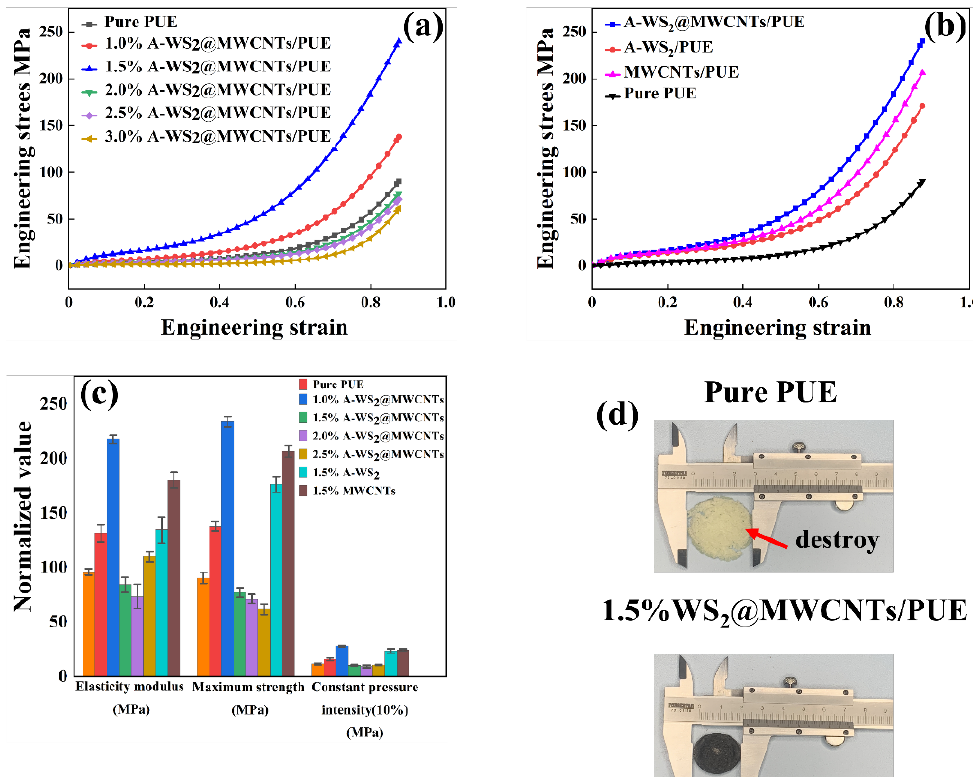
Figure 4. ( a ) Stress-strain curves of composite PUE with 1% – 3% mass fraction A-WS 2 @MWCNTs filler, ( b ) composite PUE stress-strain curves with the addition of A-WS 2 , MWCNTs, and A-WS 2 @MWCNTs fillers (the added mass fraction was 1.5%), ( c ) values of elasticity modulus, maximum strength and constant pressure intensity corresponding to the tested samples in ( a , b ), and ( d ) comparison of the damage level of pure PUE and A-WS 2 @MWCNTs/PUE after compression.